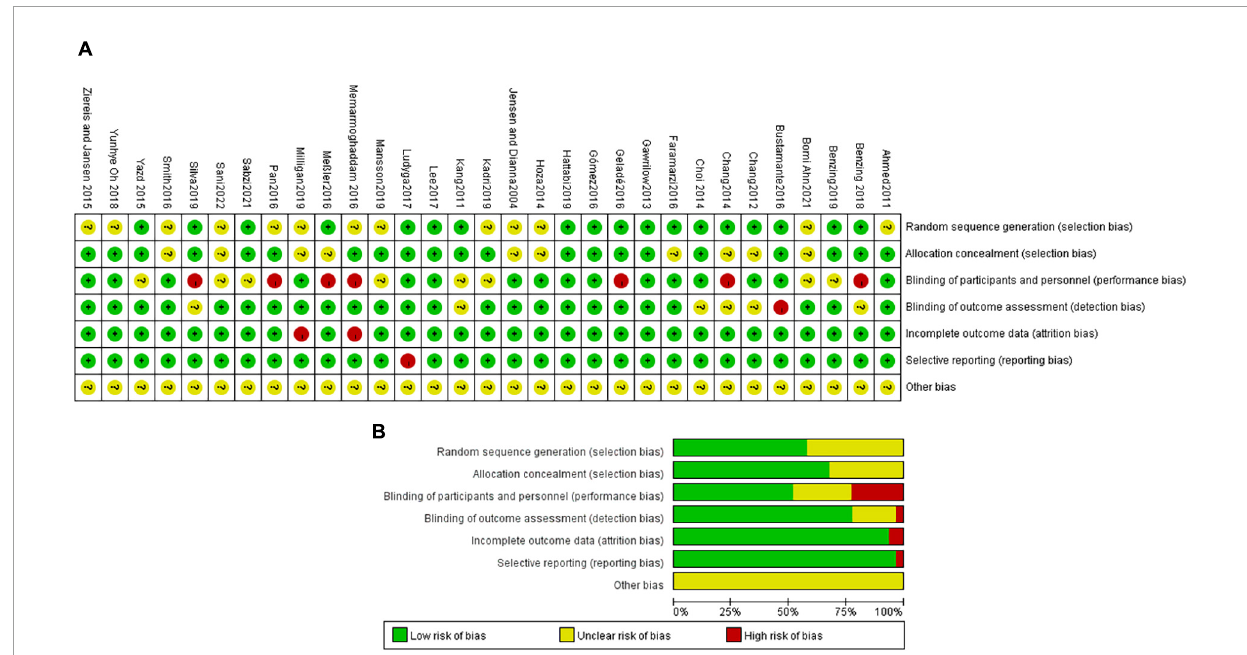
FIGURE2 (A) Methodological quality of included studies. (B) The distribution of the methodological quality of included studies.